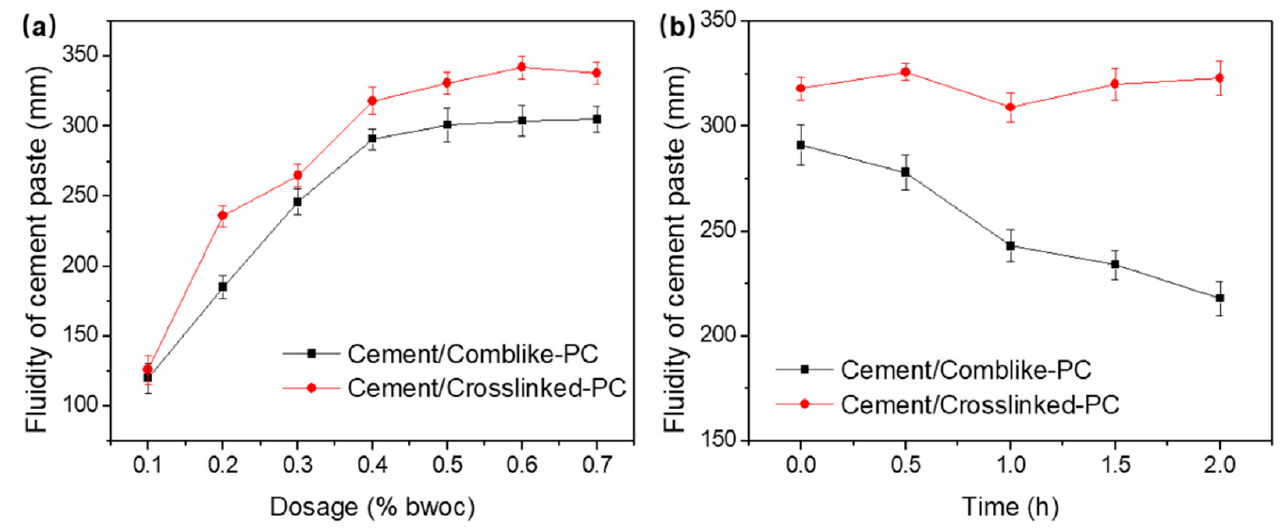
Figure 4. Fluidity ( a ) and time-dependent fluidity loss ( b ) of the cement/comb-like-PC and cement/crosslinked-PC pastes.